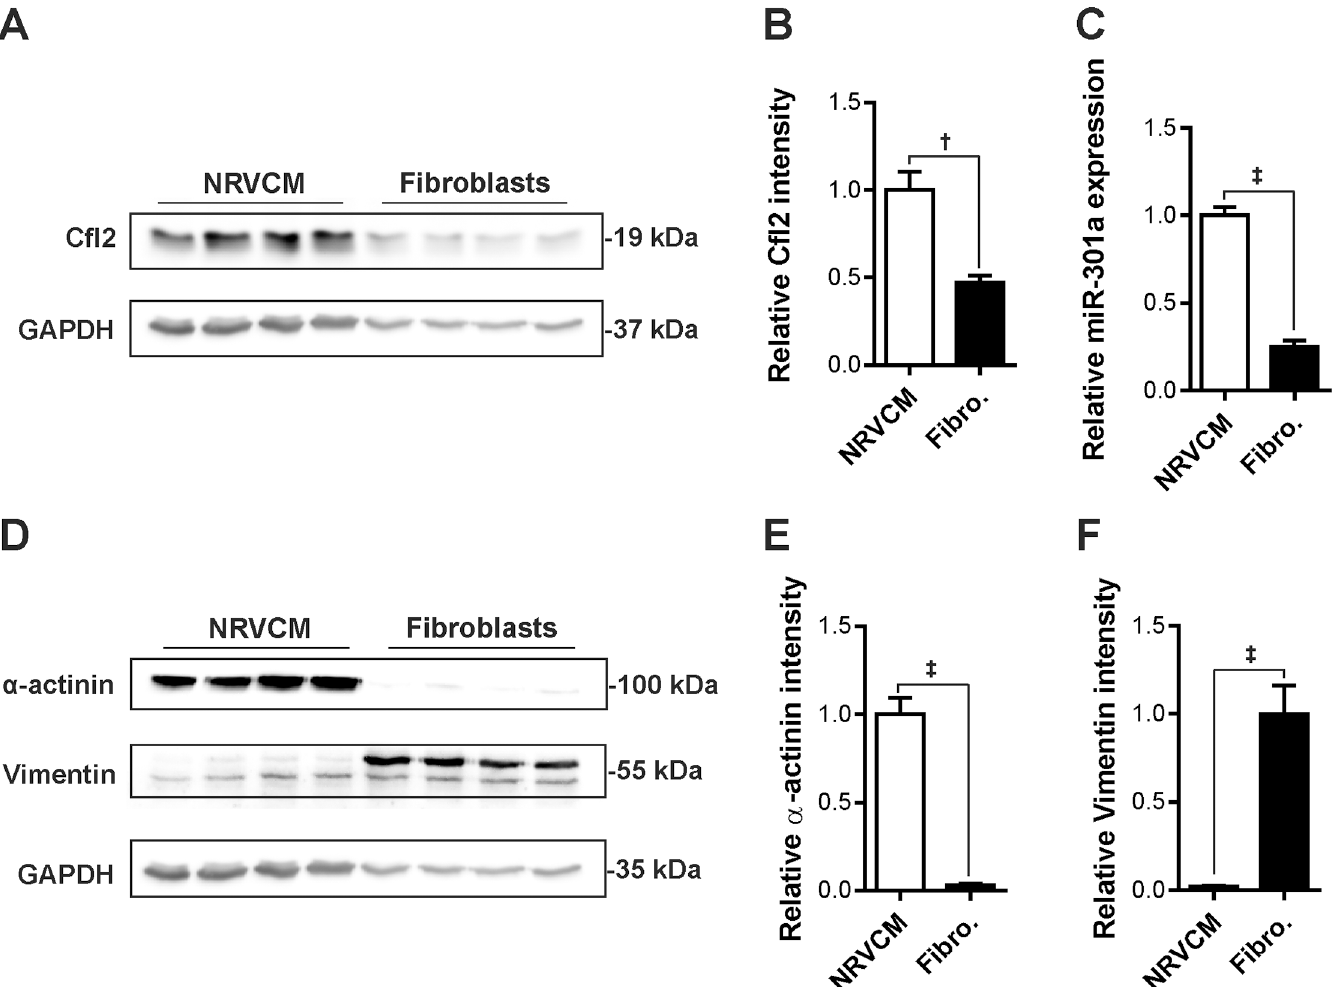
Fig 4. Expression of miR-301aand Cfl2 is higher in cardiomyocytes compared to fibroblasts. Protein and RNA was extracted from isolatedneonatal rat cardiomyocytes and fibroblasts for comparative analysisof miR-301aand Cfl2 expressionstatus. ( A ) Expression levels of Cfl2 is found to be higherin cardiomyocytes comparedto the fibroblasts shown in an immunoblot (originaluncropped blots are shown in S2B Fig, respectivedensitometry is shown as a bar graph in B ). ( C ) Expression of miR-301awas also higherin cardiomyocytes than fibroblasts as determined by quantitative real-time PCR. ( D ) α -actinin and vimentin levels were determined in the same samples as markers of cardiomyocytes and fibroblasts, respectively,to assess the purity of isolated cells (originaluncroppedblots are shown in S2C Fig, respectivedensitometry is shown as a bar graph in E, F ). N = 4 each. The statistical analysiswas carried out using two-tailedstudent’s t-test . †: p < 0.01,‡: p < 0.001.